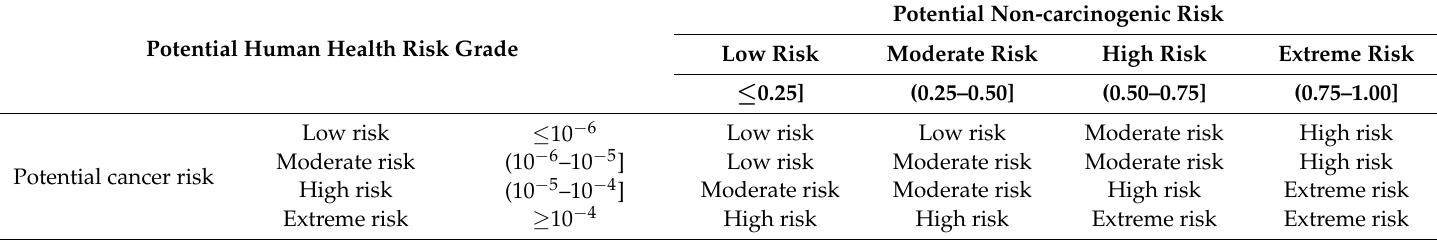
Table 10. Potential human health risk